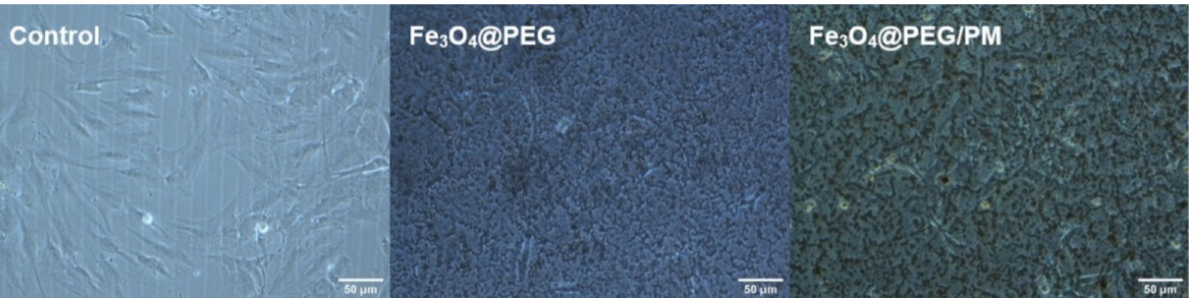
Figure 11. Morphology of MC3T3-E1 osteoblasts cultivated in the absence (control) and presence of Fe 3 O 4 @PEG and Fe 3 O 4 @PEG/PM samples.